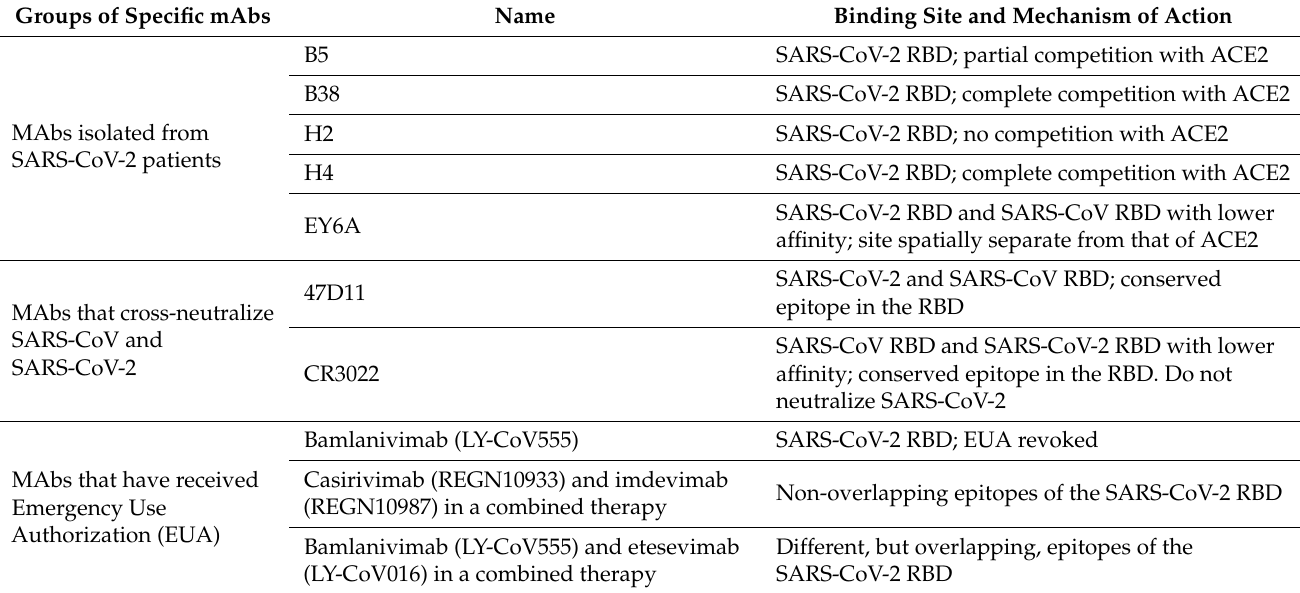
Table 2. Binding site and mechanism of action of SARS-CoV-2 specific mAbs discussed in this review. Groups of Specific